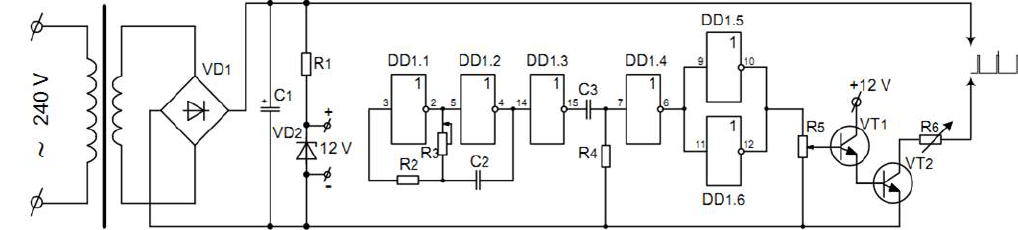
Figure 7. Circuit of Impulse Generator.